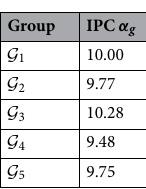
Table 5. Validation data: IPC (agreeableness) data for each symbolic